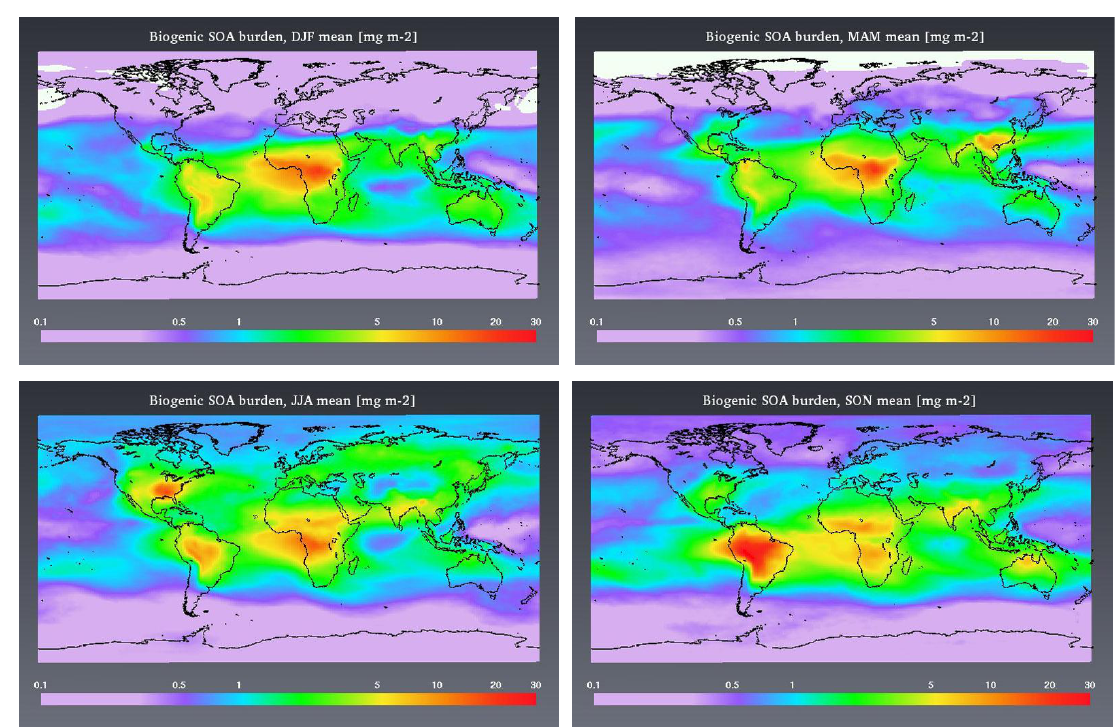
Figure 4. Seasonal mean biogenic SOA burdens